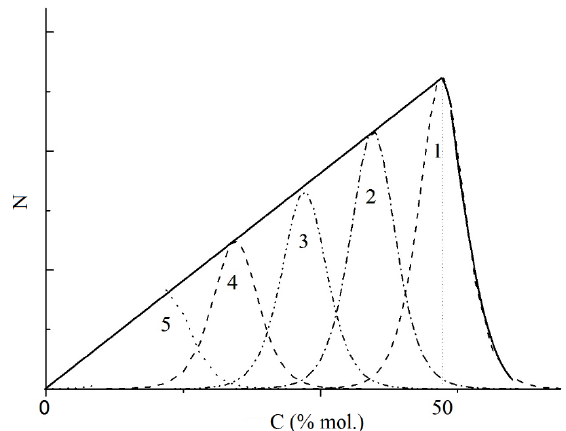
Figure 9. Schematic representation of the content of H 2 SO 4 · H 2 O hydrates (curves 1–5 for n = 1, 2, 3, 4, and 6.5) and its sum (solid line) depending on the concentration of sulfuric acid.